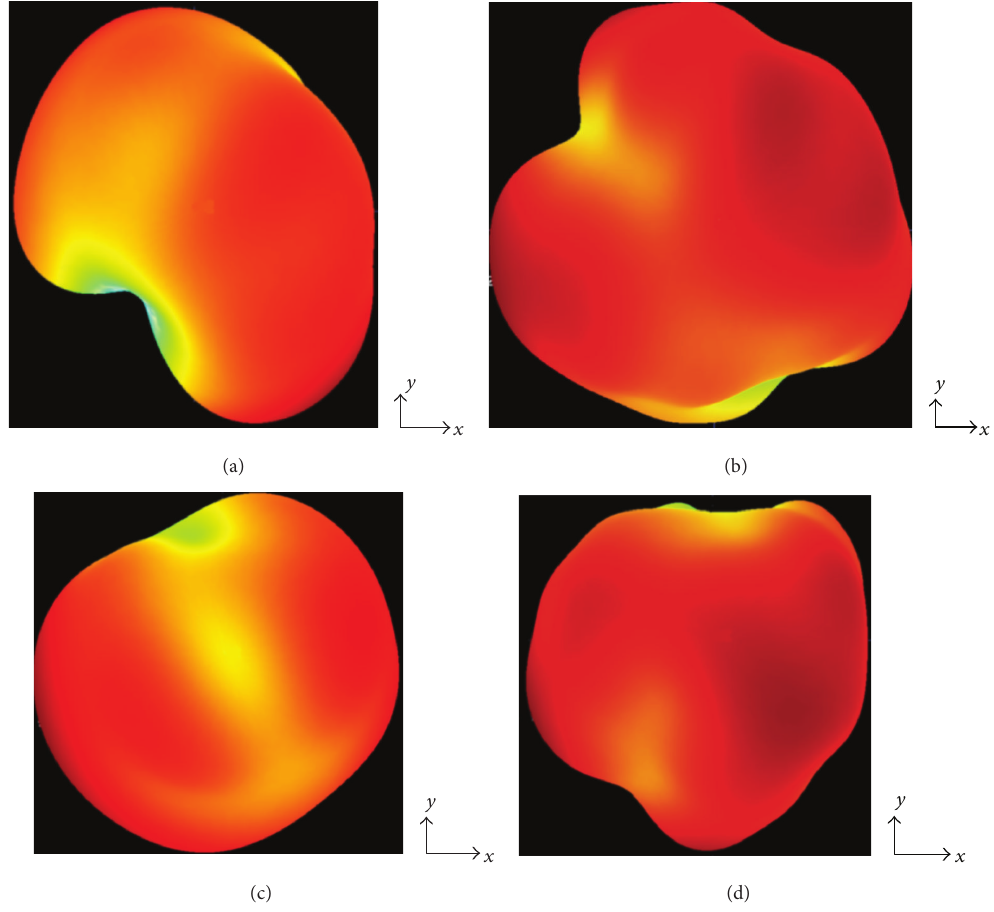
Figure 9: Measured three-dimensional radiation patterns of two antennas in the MIMO system: (a) antenna 1 at 890 MHz, (b) antenna 1 at 2600 MHz, (c) antenna 2 at 890 MHz, and (d) antenna 2 at 2600